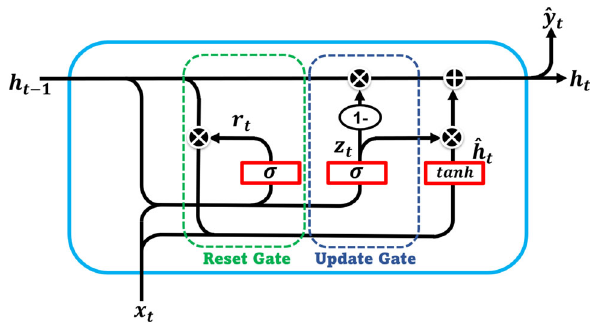
Fig. 2 Architecture of gated recurrent